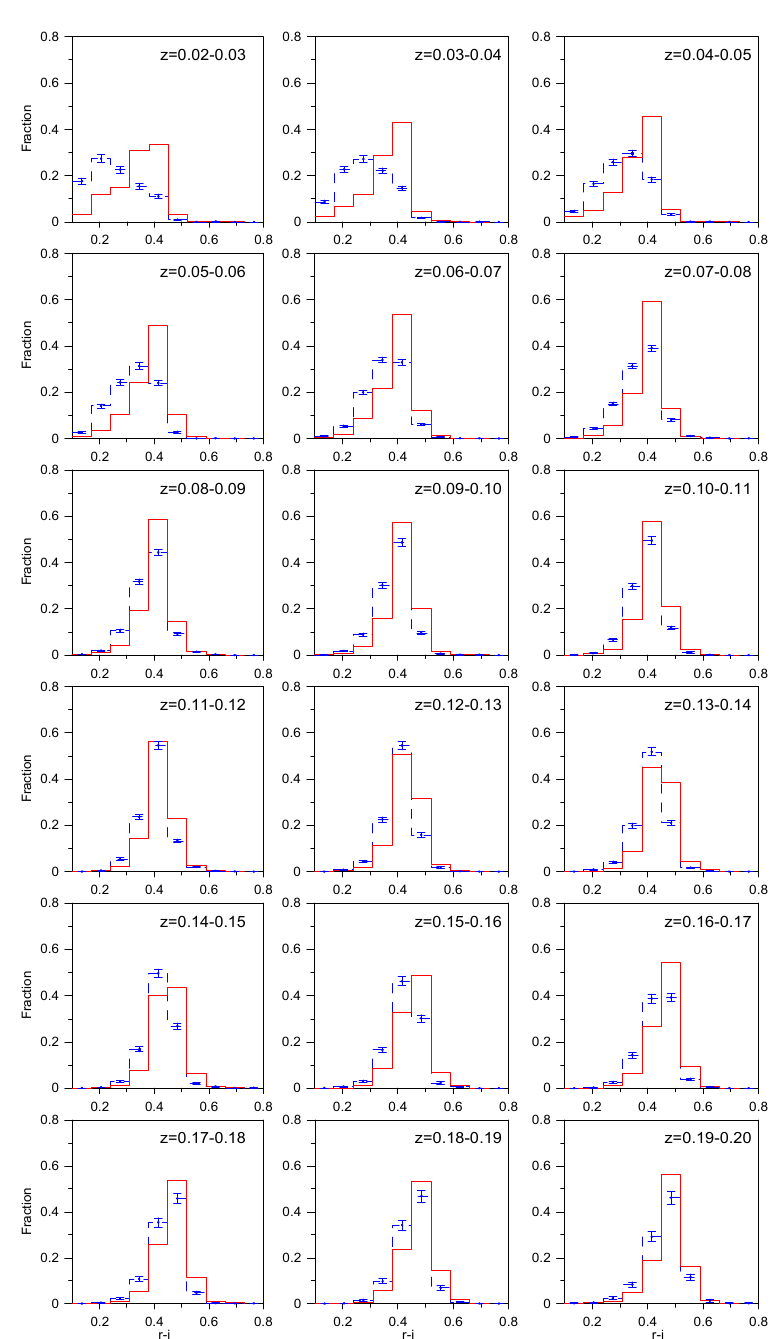
Fig. 4. Distribution of r – i colors. Designations are the same as in Figure